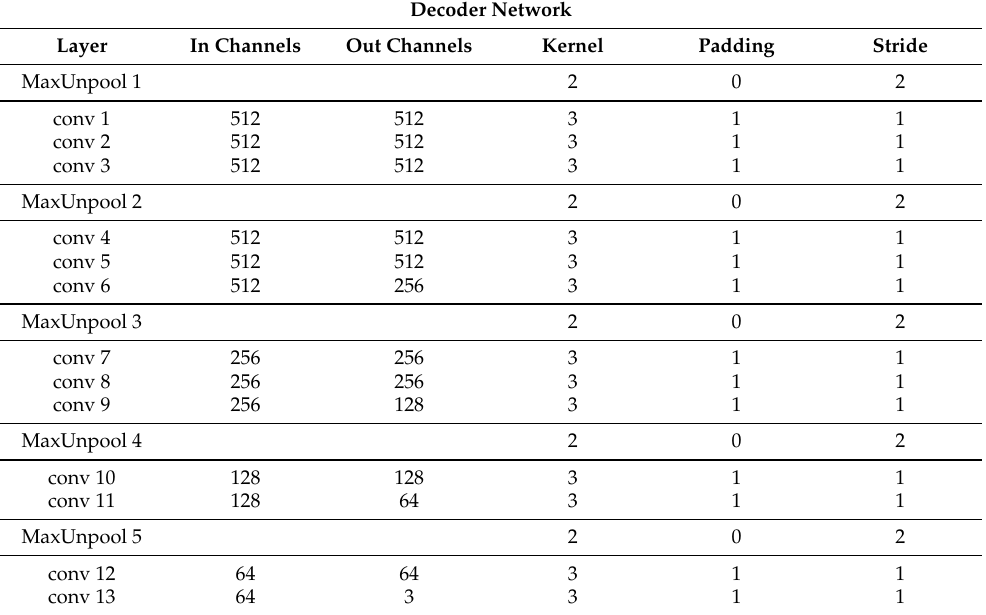
Table 3. Decoder network